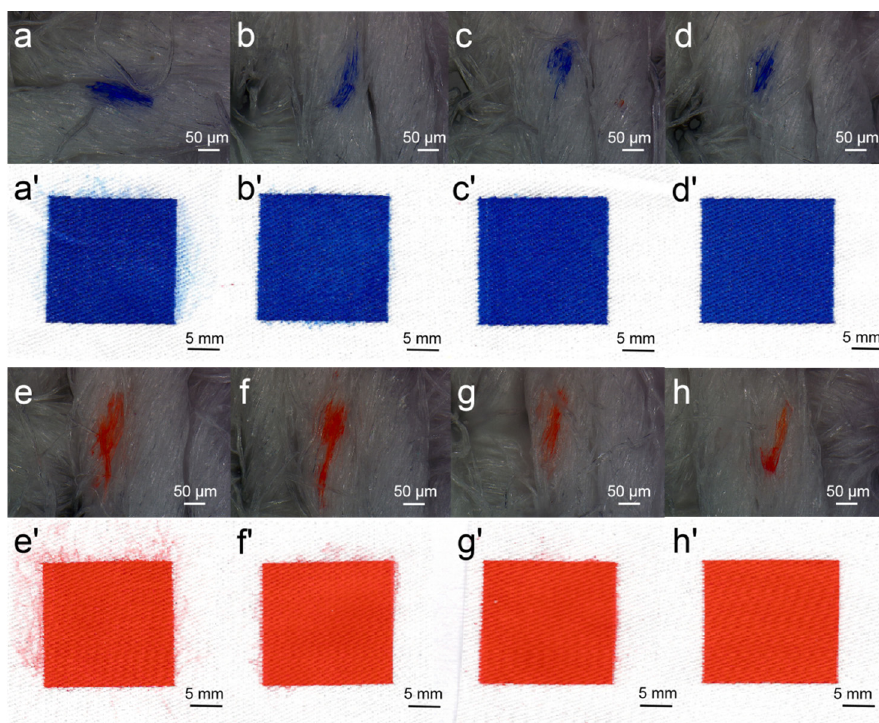
Figure 6. Ink-jet ink droplet spreading and printed images: ( a – d ) 120 mmol/L Reactive Blue 49 solutions with different concentrations of DEG: ( a ) 0, ( b ) 1, ( c ) 2, and ( d ) 3 mol/L. ( a’ – d’ ) Corresponding photos of cotton fabrics treated by Reactive Orange 13 from ( a – d ); ( e , f ) 120 mmol/L Reactive Orange 13 dye solutions with different concentrations of DEG ( e , f ): ( e ) 0, ( f ) 1, ( g ) 2, and ( h ) 3 mol/L; ( e’ – h’ ) corresponding photos of cotton fabrics treated by Reactive Blue 49 from ( e , f ).